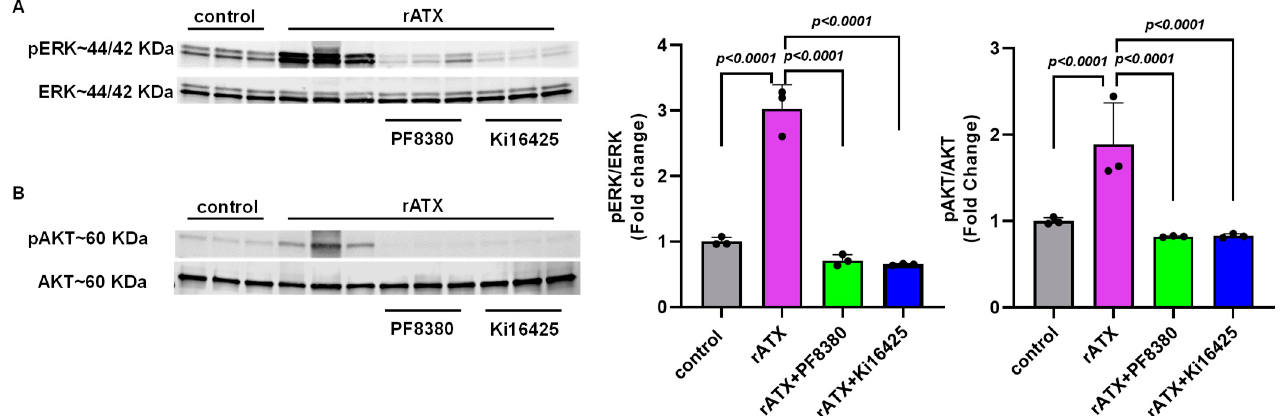
Figure 4. AKT/ERK signaling in VSMCs induced by ATX. ( A ) Western blot analysis of phosphory- lated ERK was performed in mouse VSMCs with control (no rATX), rATX (10 nM), PF8380 (10 µ M), or Ki16425 (10 µ M) treatment. ( B ) Western blot analysis of phosphorylated AKT was performed in mouse VSMCs with control (no rATX), rATX (10 nM), PF8380 (10 μ M), or Ki16425 (10 μ M) treat- ment. All values are expressed as mean ± SD ( n = 3) with p -values calculated by one-way ANOVA. rATX-recombinant active autotaxin; PF8380—autotaxin inhibitor; Ki16425—LPAR1-3 inhibitor.